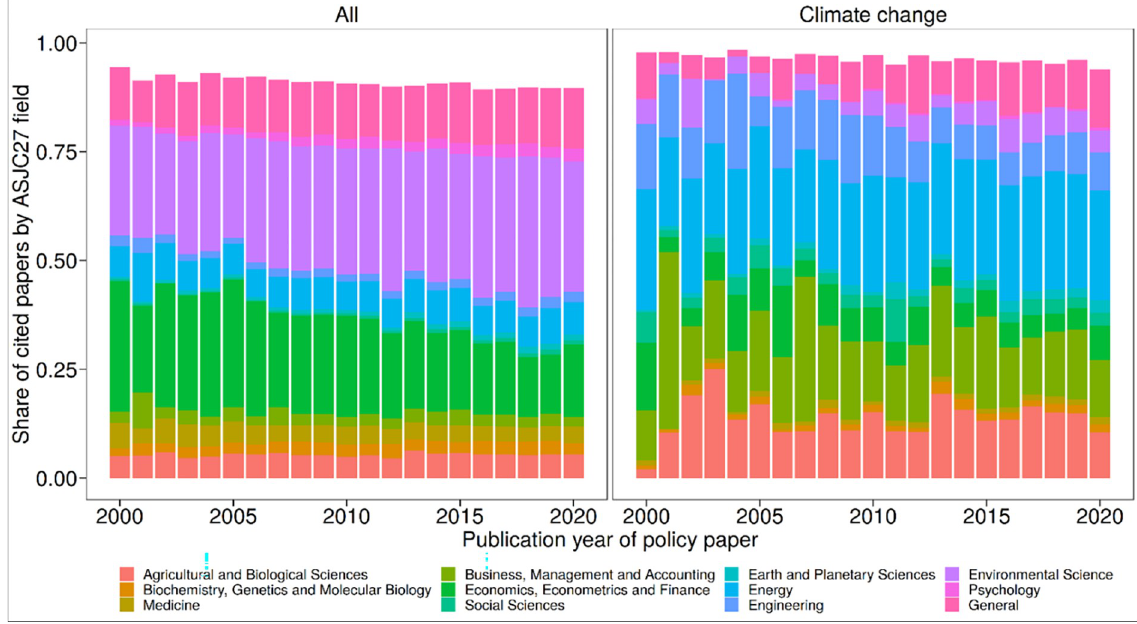
Fig 11. Fields of papers cited in policy documents (an interactive version with all ASJC27 fields is available at: https://s.gwdg.de/ QTl1nm).